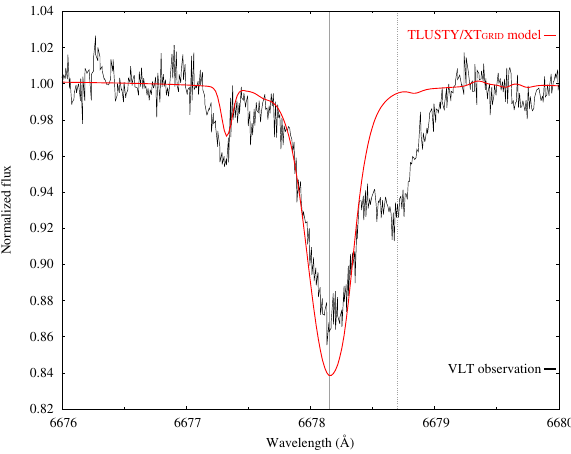
Figure 1. Isotopic shifts in the optical spectrum of Feige86 are most remarkable in the helium lines. The He i 6678 Å line shows the iso- topic separation of 3 He (dashed line) and 4 He (solid line). Verti- cal stratification causes the line profiles appear too strong in the wing and too shallow in the core when compared to homogeneous models. Isotopic shift broadens the lines and in the most extreme cases, such as the He i 6678 Å line, it separates the line into com-